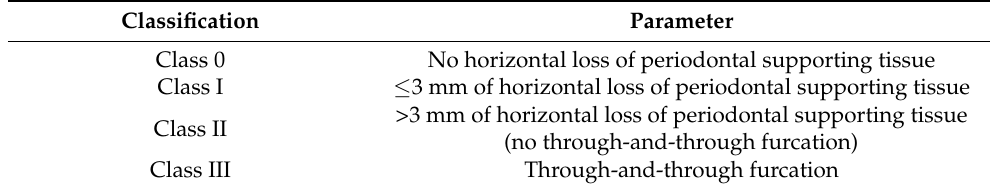
Table 1. Furcation